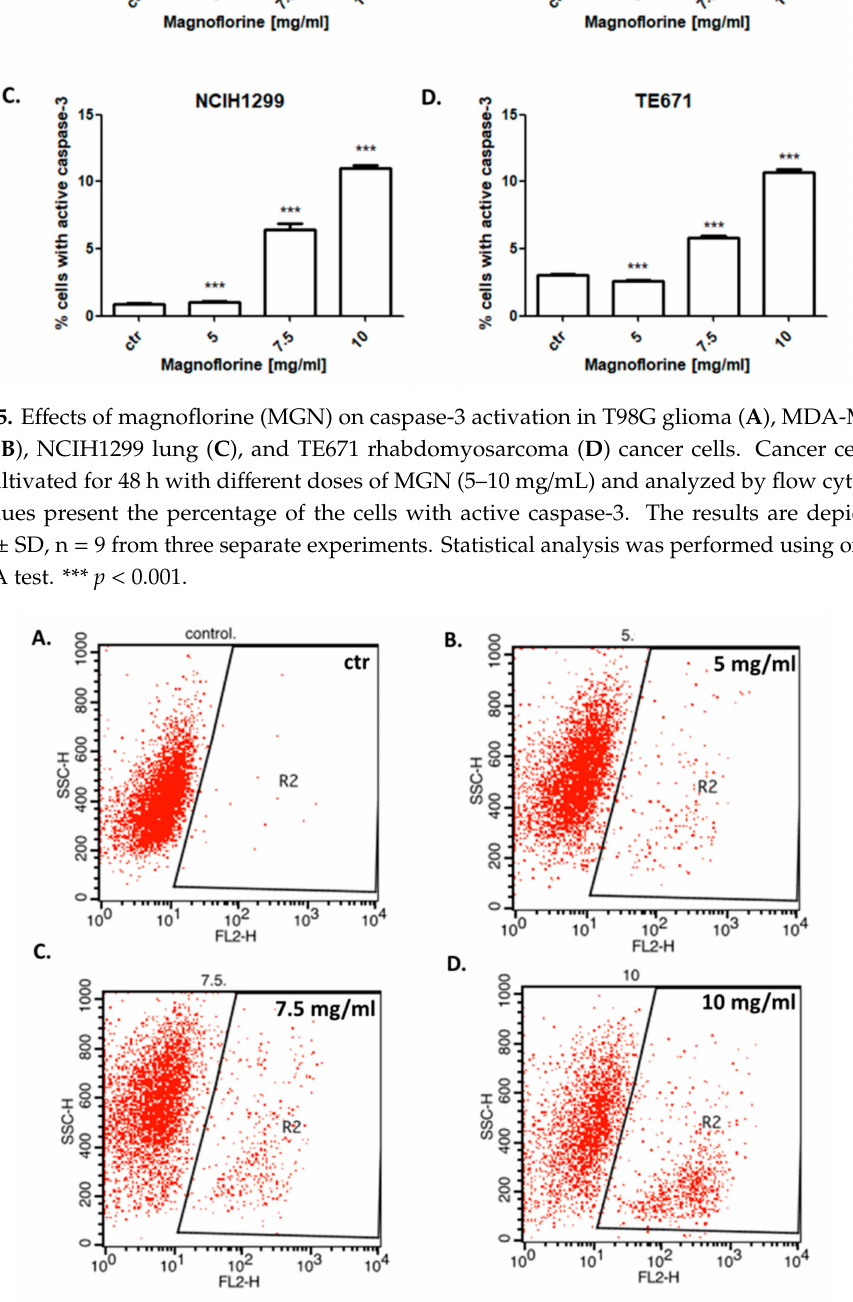
Figure6. RepresentativedotplotsoftheflowcytometryanalysisofT98Ggliomacellsafter48htreatment with medium (ctr) ( A ) or magnoflorine (5 mg / mL) ( B ), 7.5 mg / mL ( C ), and 10 mg / mL ( D ); n = 9 per concentration from three independent experiments. R2-cells with active caspase-3 (apoptotic